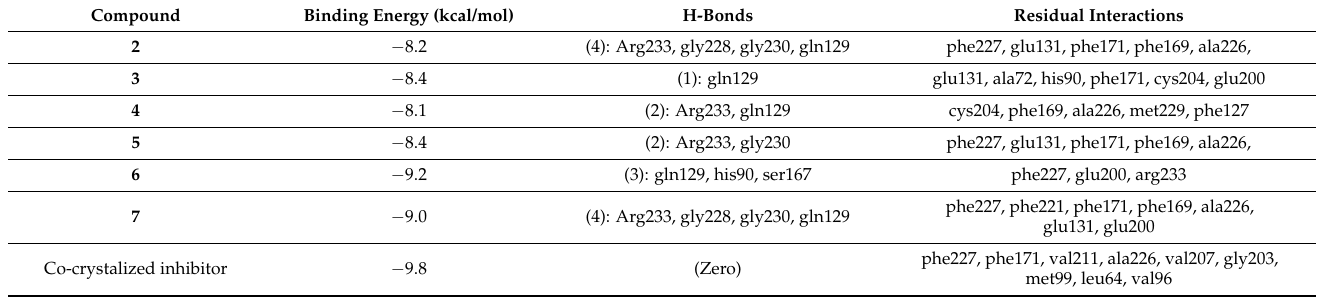
Table 3. Interactions of the docked compounds with bacterial PheRS.